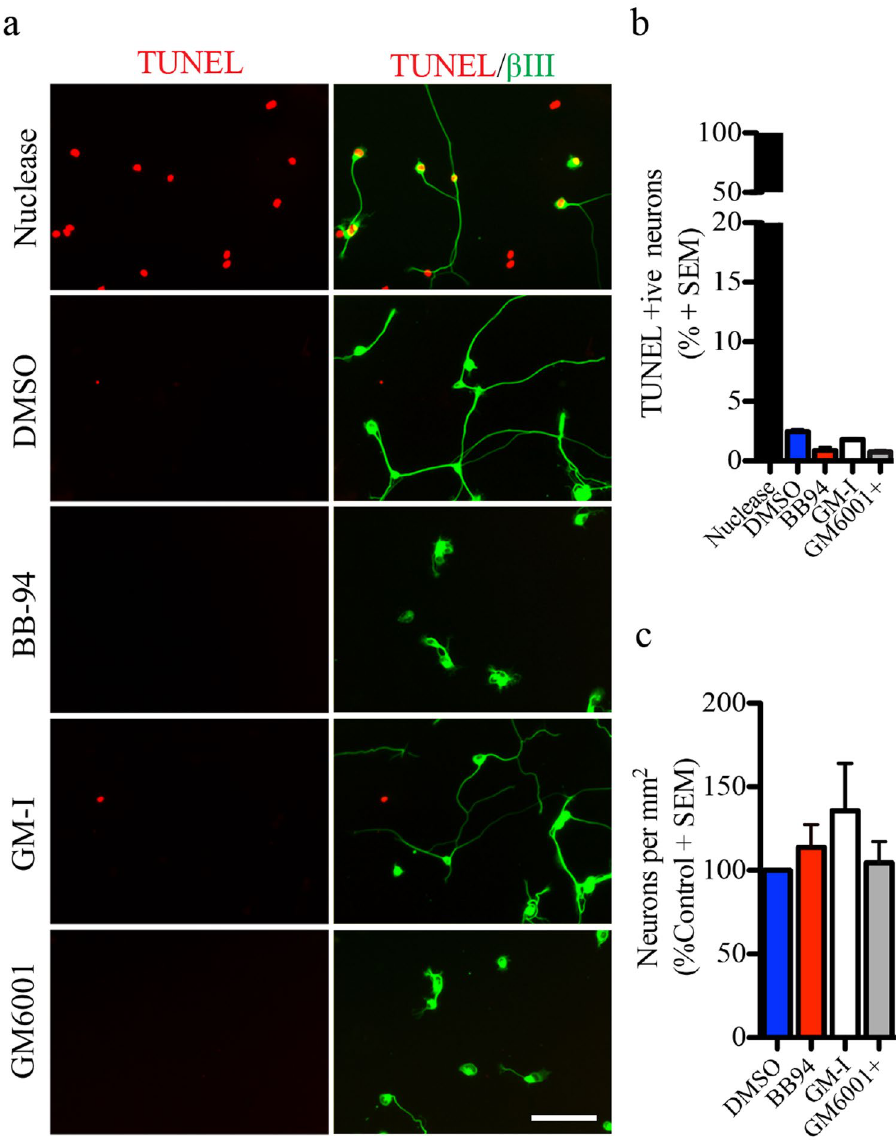
Figure 2. Pan-metalloproteinase inhibitors do not affect adhesion or cell death of DRG neurons. ( a ) A TUNEL assay was performed in embryonic DRG neurons (E18-19) seeded on a PLL substrate and treated with a vehicle control (DMSO), metalloproteinase inhibitors (BB-94 and GM6001) or GM-I. Neurons were stained with anti- β III tubulin, Hoechst and TUNEL. As a positive control for the TUNEL assay, neurons were pretreated with a DNA nuclease. ( b , c ) Total number of apoptotic neurons ( b ) and total neurons ( c ) present after indicated treatments. For TUNEL, the data are shown as a percentage of TUNEL-positive neurons. For total number of neurons, data have been normalized to control DMSO. N = 4 from independent cultures. Data are shown as mean + S.E.M. Scale bar, 100 μ